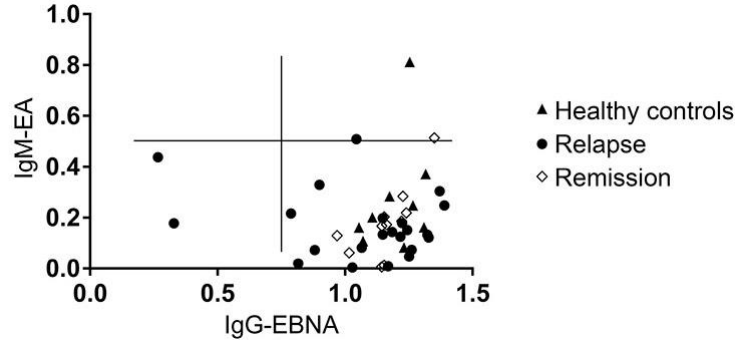
Figure 7. No association between MS and the reactivation of a latent EBV infection. Scatter plot for EBV nuclear antigen (EBNA) IgG and EBV early antigen (EA) IgM plasma titers in the different subgroups. Results for individual donors are displayed as circles.